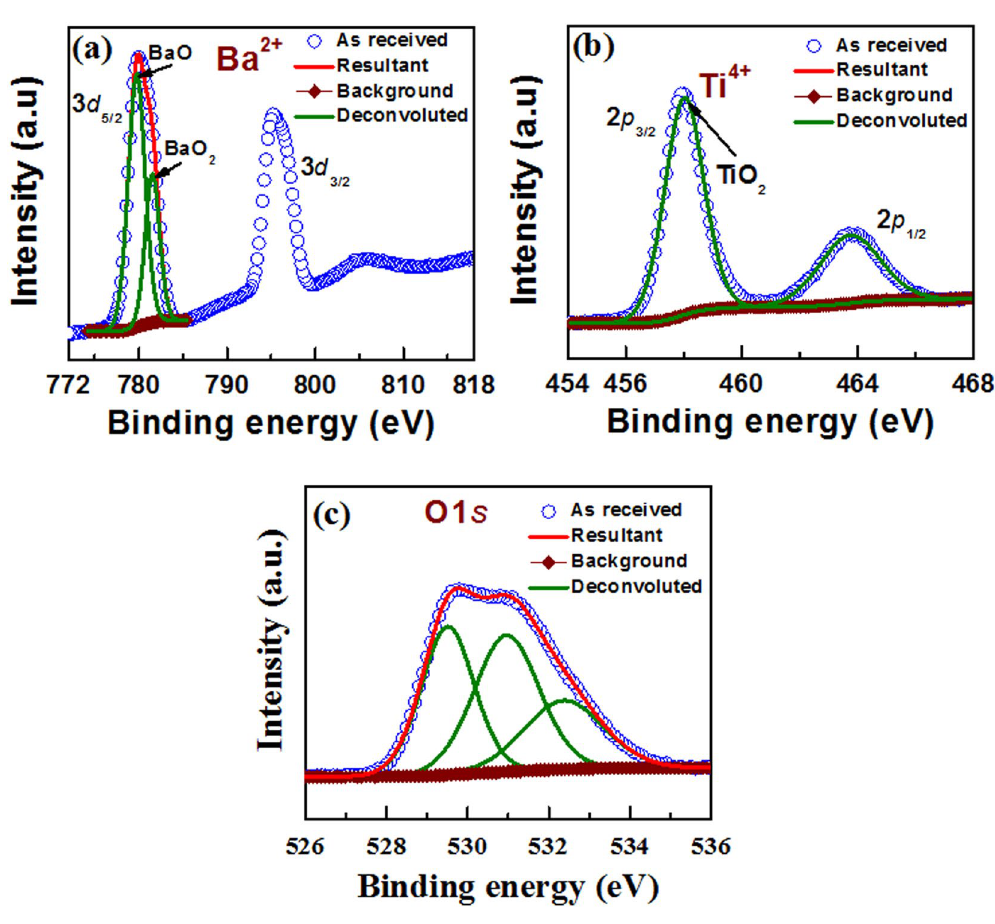
Figure 3. XPS characteristics of ( a ) Ba 3d , ( b ) Ti 2p , and ( c ) O 1s spectra from the BaTiO x